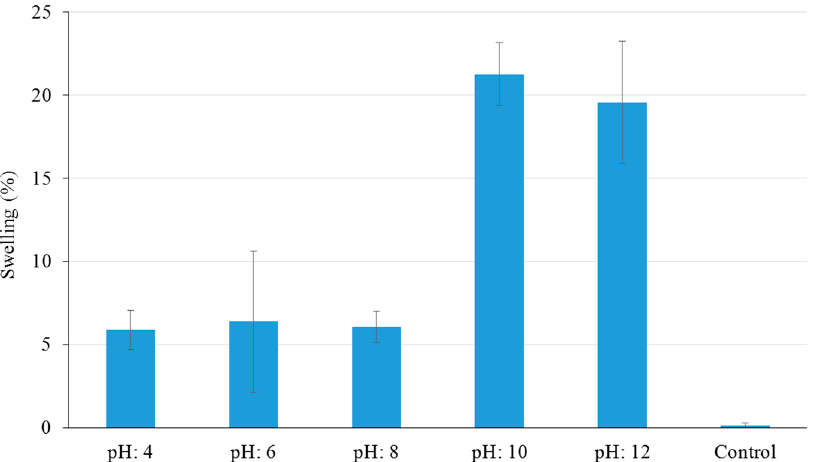
Figure 6. Swelling properties of CHX/Metr-loaded NCHGs in different pH Britton–Robinson buffer solutions after 168 h. Control is the NCHG structure without drugs, error bars represent the standard deviation (SD) of five parallel measurements.